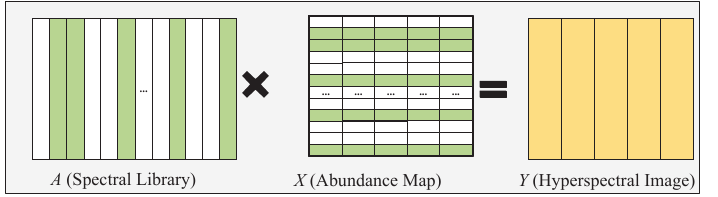
Figure 1. Illustration of the hyperspectral sparse unmixing problem, Y is the image to be unmixed, A is the large-scale spectral library, and X is the obtained abundance matrix. Only colored active endmembers participate in the reconstruction of